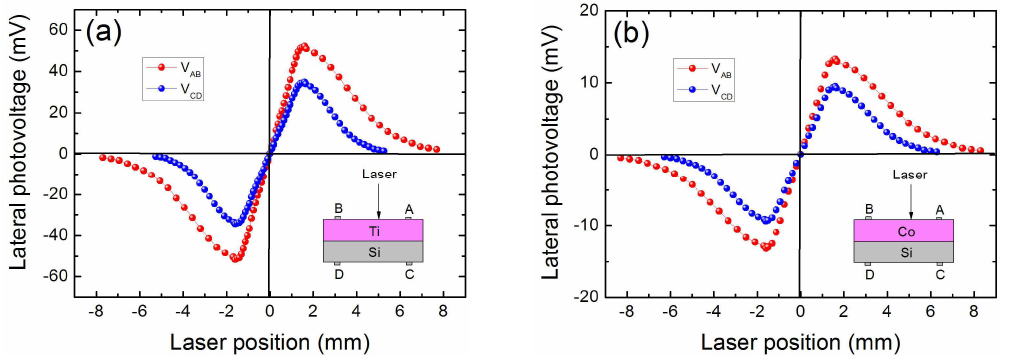
Figure 3. (a) LPV measurement on both metal and semiconductor sides in MS structure of Ti(6.2 nm)/Si. (b) LPV measurement on both metal and semiconductor sides in MS structure of Co(6.2 nm)/Si. Here the contacts’ distance is 3.2 mm, and the laser wavelength and power are 632 nm and 3 mW,